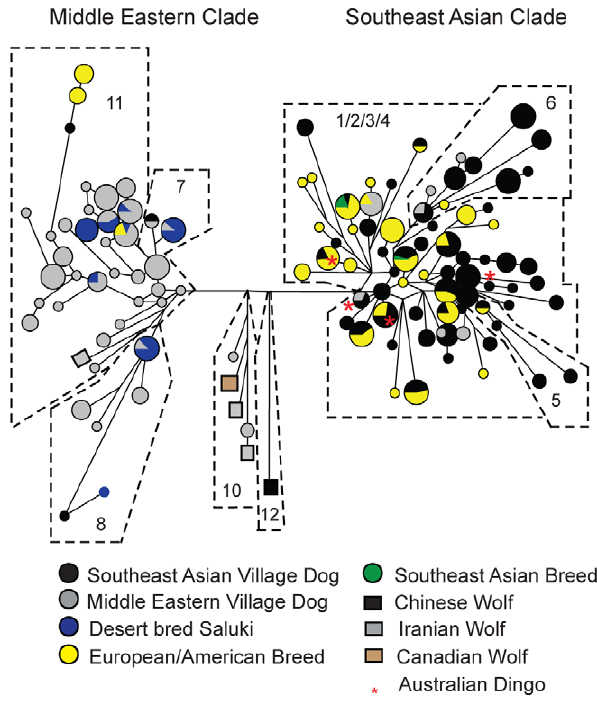
Figure 3. Village and breed dog Y chromosome SNP-STR haplotype networks. Networks of dog (circles) and wolf (squares) NRY SNP-STR haplotypes, including 300 village dogs/dingoes, 124 breed dogs, and 7 wolves. Size of circle is proportional to sample size, except that the larges circle represents 18–50 individuals, and line lengths are proportional to the number of mutational steps. Subclades are numbered corresponding to SNP haplotypes in Figure 1, and are circumscribed by dashed black lines.